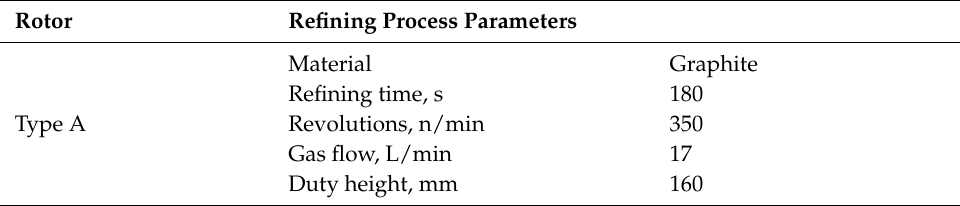
Table 4. Type B rotor—setting of refining technological parameters.